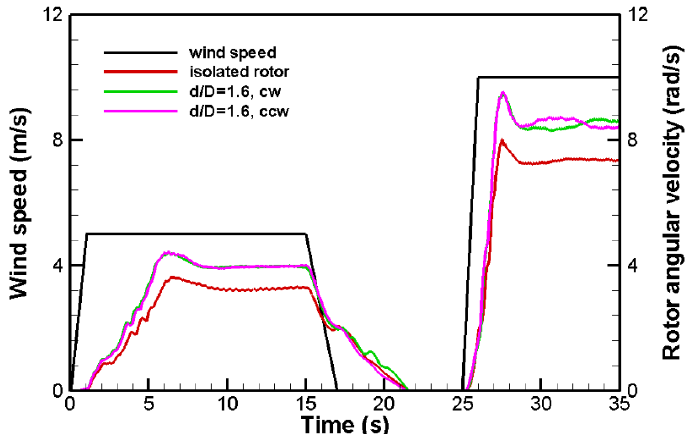
Figure 8. Wind speed and the induced angular velocities of two closely-placed counter-rotating rotors with the pair spacing at d / D = 1.6. The green and purple curves are for clockwise (cw) and counter-clockwise (ccw), respectively. The absolute values of angular velocity were used for the counter-rotating rotors.